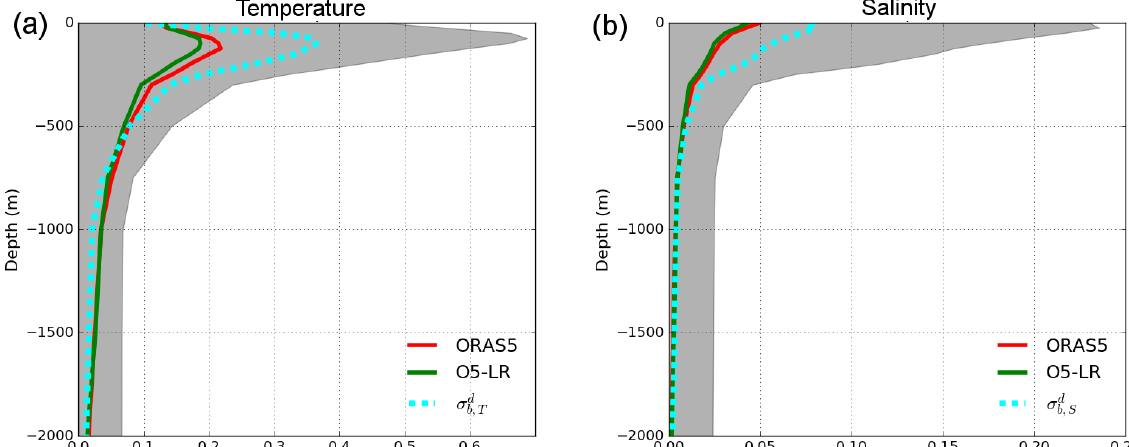
Figure 14. Vertical profiles of ensemble spread of (a) temperature (in K) and (b) salinity (in psu) from ORAS5 (red solid) and O5-LR (green solid). Ensemble spread is calculated using model background values, temporally averaged over the 2010–2013 period and spatially averaged over the tropics (30 ◦ S to 30 ◦ N). σ d is the diagnosed ORAS5 BGE standard deviation (cyan dashed) using the Desroziers method b (Desroziers et al., 2005). The specified BGE standard deviation ( σ s ) is shown as the grey shaded area for b